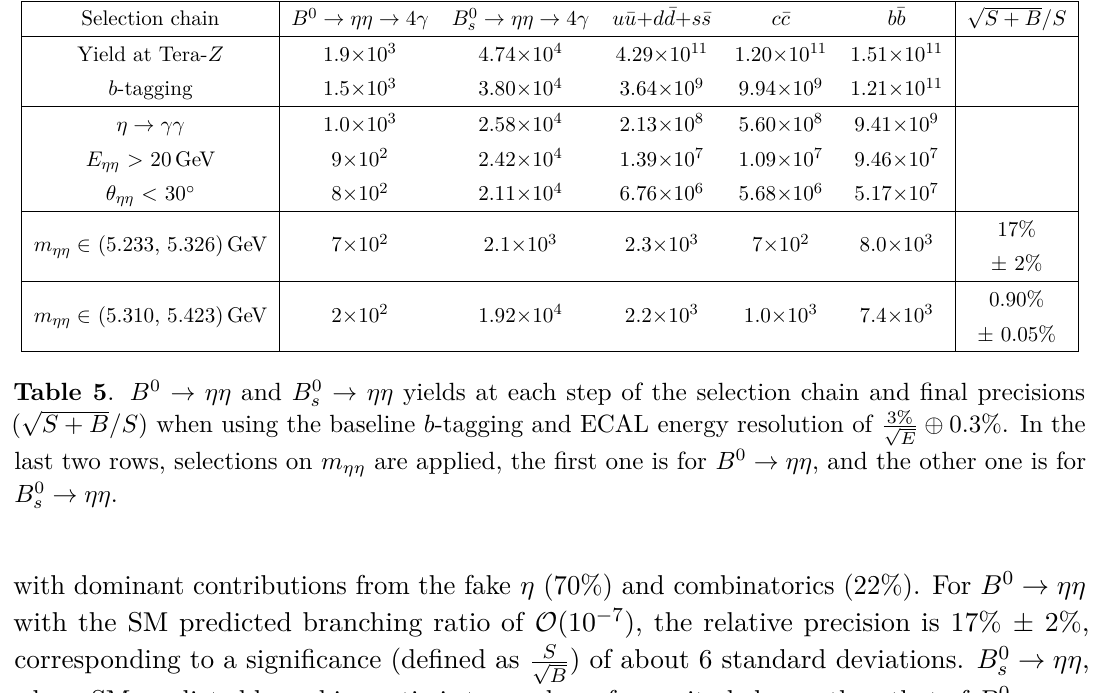
Figure 7 . (a) Background components for B 0 decays of B ± to π ± π 0 π 0 . The two resonances with m 2 D 0 , respectively.